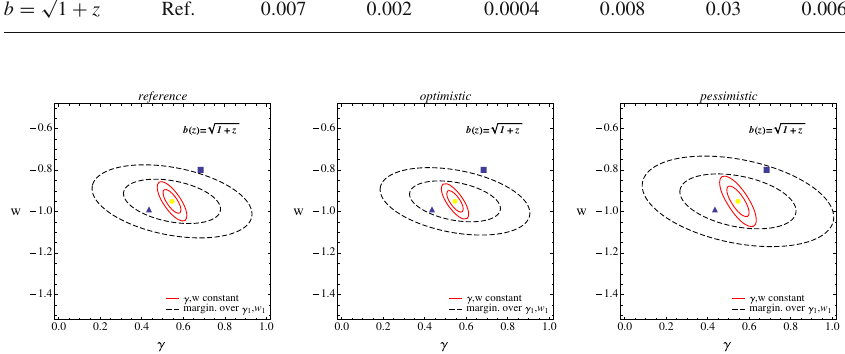
Fig. 21 γ -parameterization. 1 and 2 σ marginalized probability regions obtained assuming constant γ and w (red solid curves) or assuming the parameterizations (I.8.5) and (I.8.2) and marginalizing over γ w 1 (black dashed curves); marginalized error values are in columns dots represent the fiducial model, the triangles a f ( R ) model and the squares mark the flat DGP